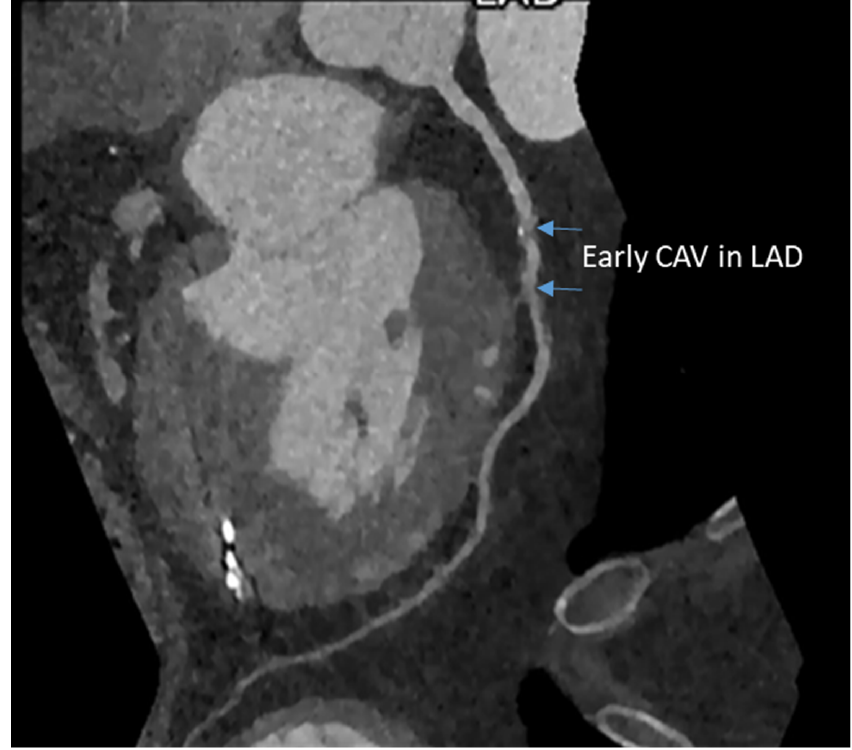
Figure 4. Early CAV in the left anterior descending coronary artery in an 18 yr old male six years after heart transplantation.